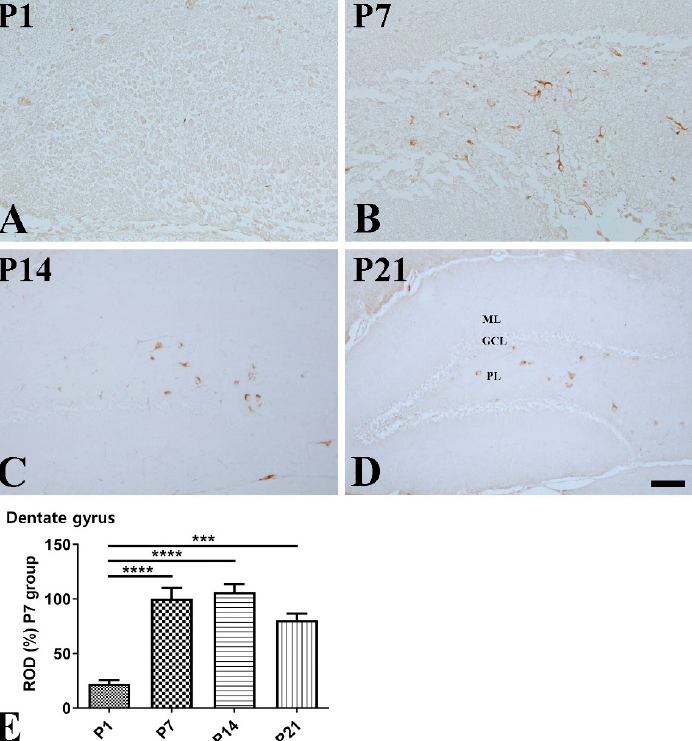
Figure 4. Immunohistochemical staining for somatostatin (SST) in the mouse dentate gyrus at P1 ( A ), P7 ( B ), P14 ( C ), and P21 ( D ). GCL granule cell layer; ML molecular layer; PL polymorphic layer. Scale bar = 50 µm. ( E ): The number of SST-immunoreactive cells in the dentate gyrus at P1, P7, P14, and P21 are expressed as a percentage of the value in the P7 group ( n = 5 per group; *** p < 0.001 and **** p < 0.0001). All data are represented as the mean ± standard error of the mean.